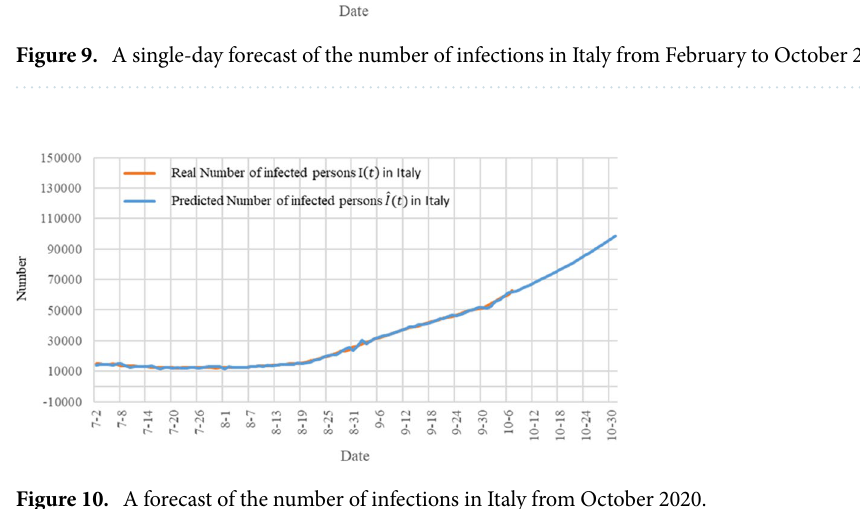
Figure 10. A forecast of the number of infections in Italy from October